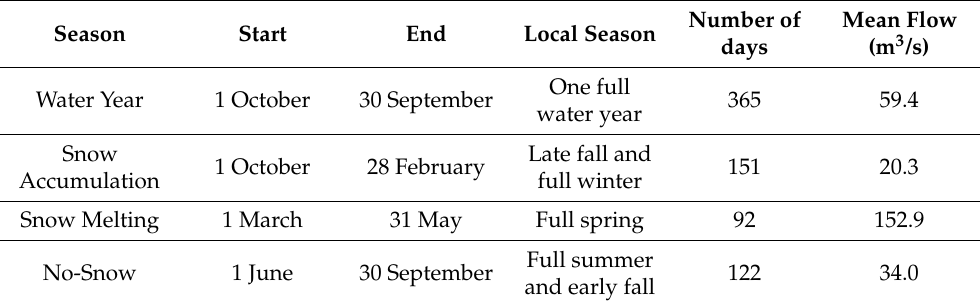
Table 2. Seasons for the analyses.